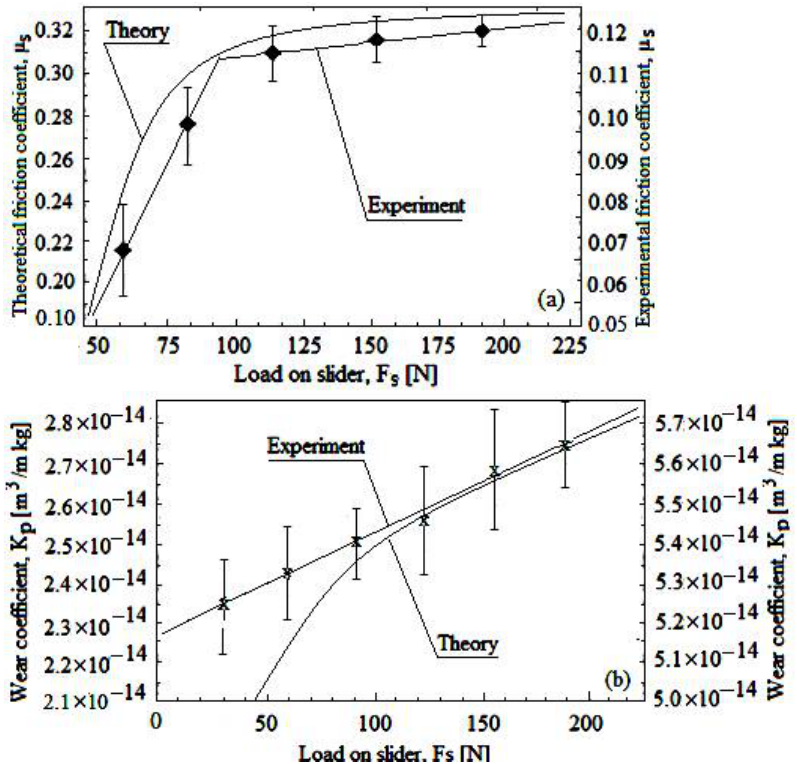
Figure 5. Variation of friction coefficient, µ s ( a ), and of wear rate, K p ( b ) depending on slider pad load at the separation surfaces (theoretical and